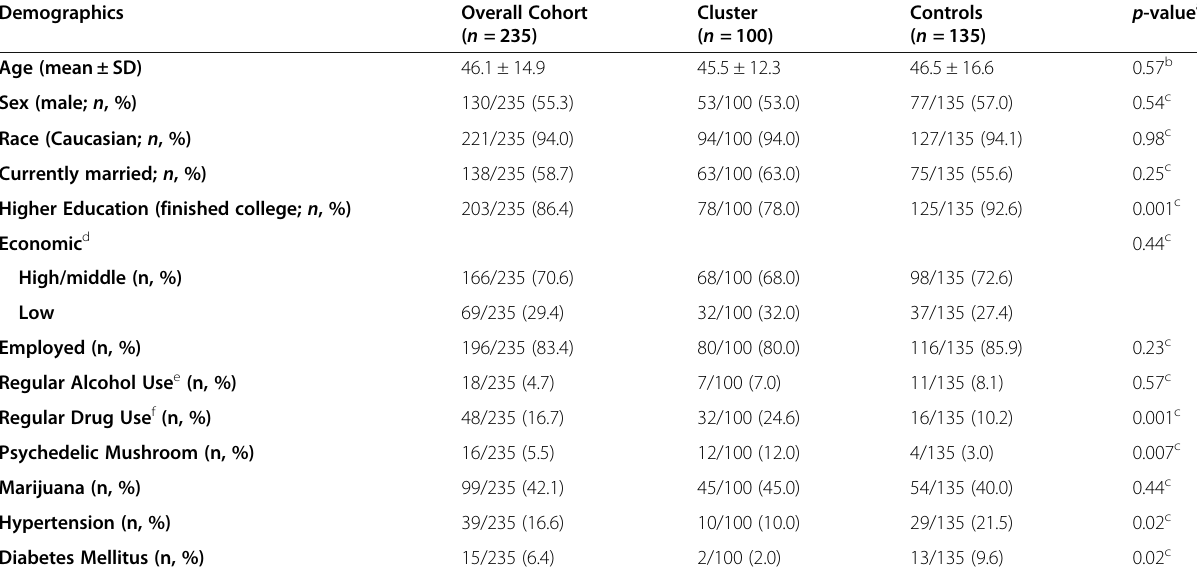
Table 1 Demographics and Medical History of Cluster Headache patients and controls